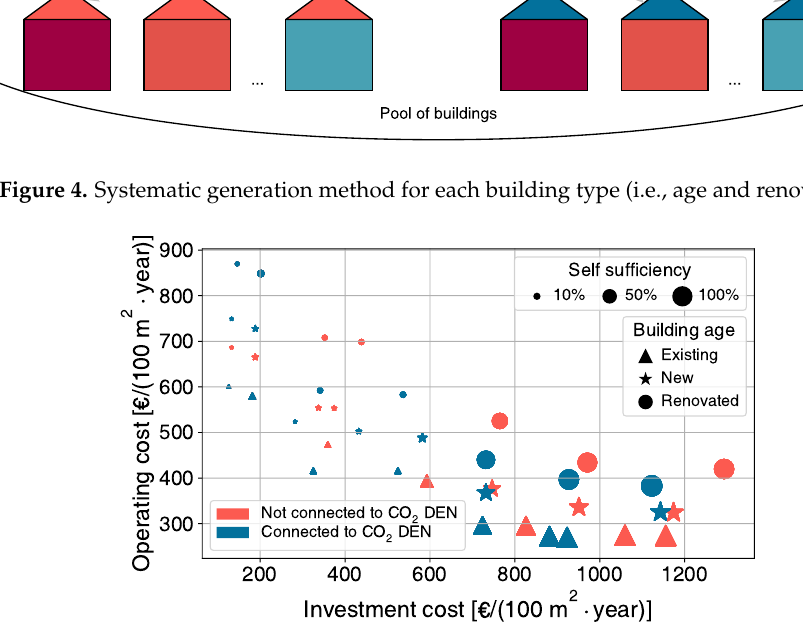
Figure 5. Pareto frontier of residential SFH with different utility configurations and renovation